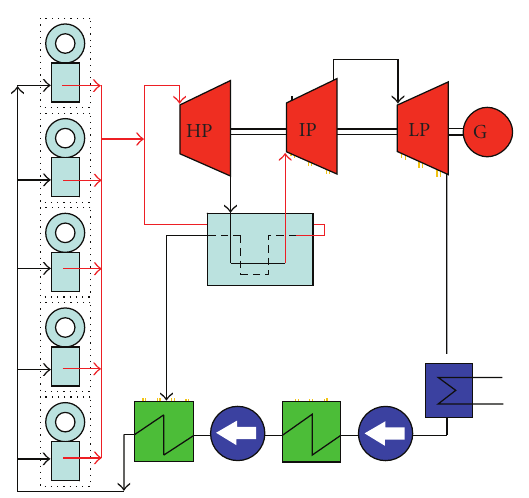
Figure 5: Deployment mode of MHTGR-250 SC plant with life steam reheat